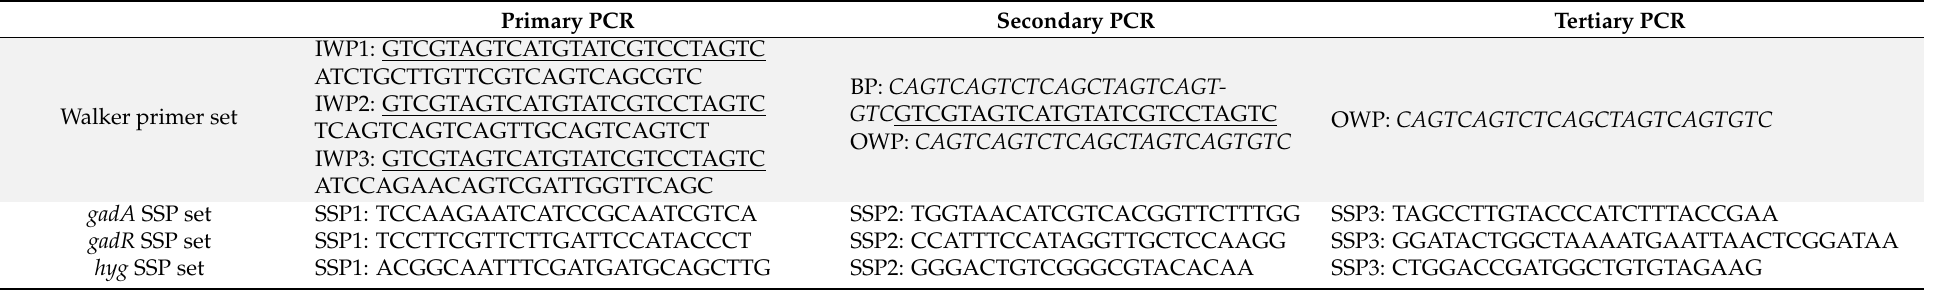
Table 1. Primers used in this